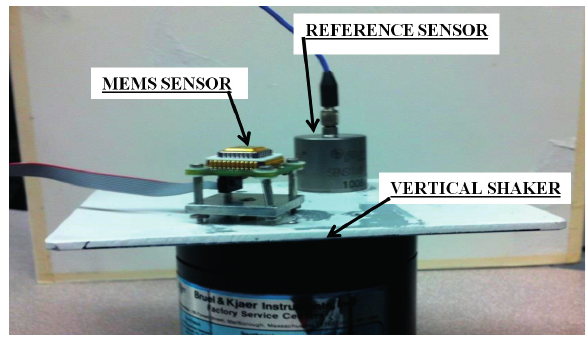
Figure 20. Setup for the shaking table test (periodic waves